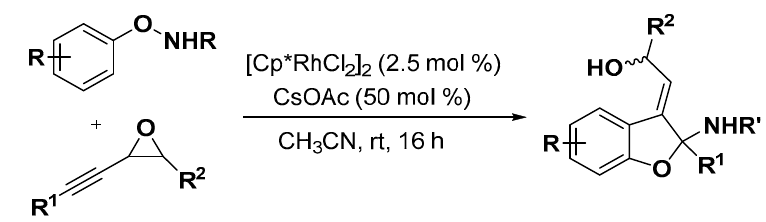
Scheme 4. The proposed reaction mechanism.